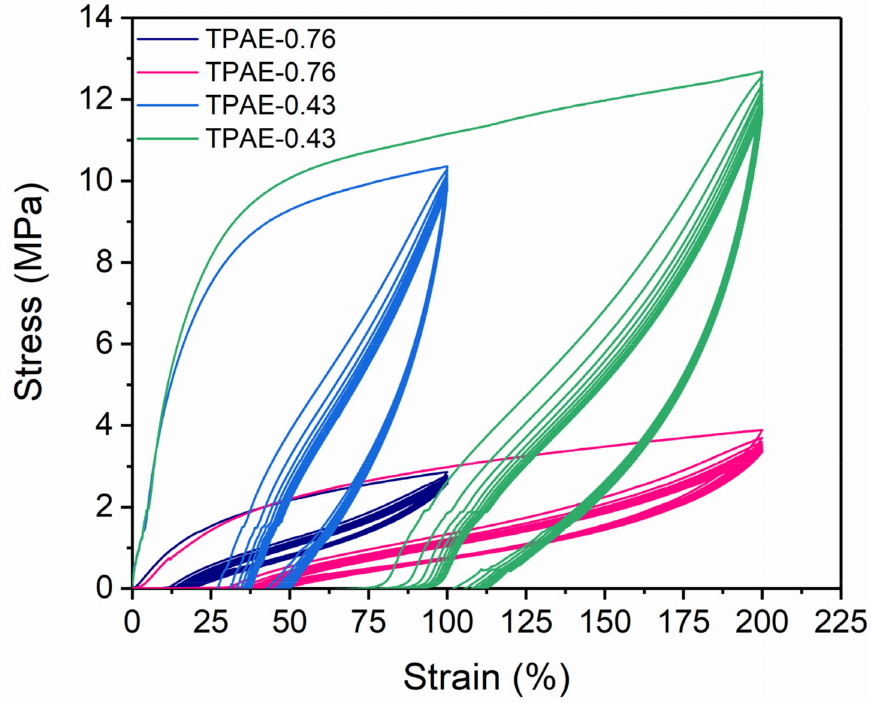
Figure 11. Selected cyclic tensile stress–strain curves of TPAE